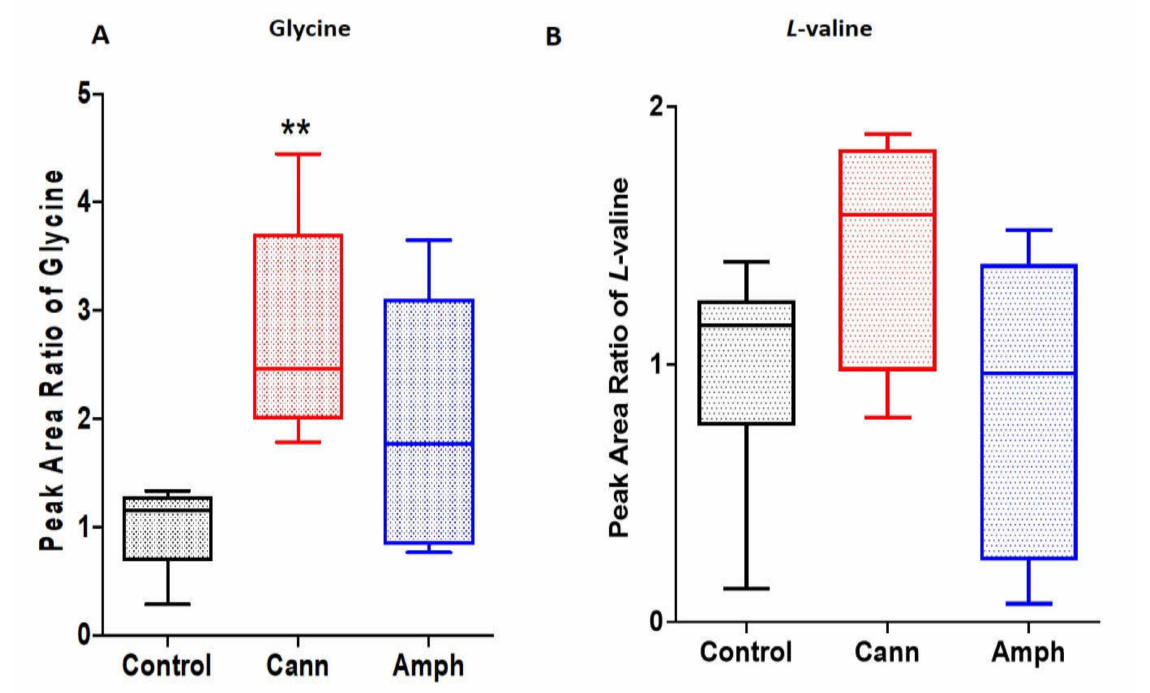
Figure 2. Effects of cannabis or amphetamine on selected amino acids in cannabis or amphetamine use disorder patients. ( A ) Kruskal–Wallis test followed by Dunn’s post hoc analysis showed a significant increase on glycine in the cannabis compared with the control group. ( B ) Kruskal–Wallis test followed by Dunn’s post hoc analysis did not show significant differences in l -valine between the three groups. (** p < 0.01). Cann, cannabis. Amph,